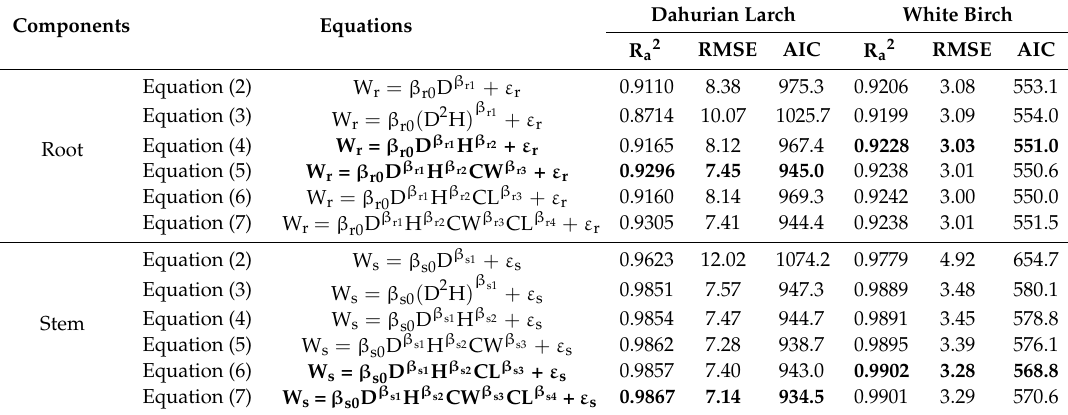
Table 3. Goodness-of-fit statistics of six nonlinear biomass equations based on different predictor variables for the different tree biomass components of two tree species. RMSE = root mean squared error; AIC = Akaike information